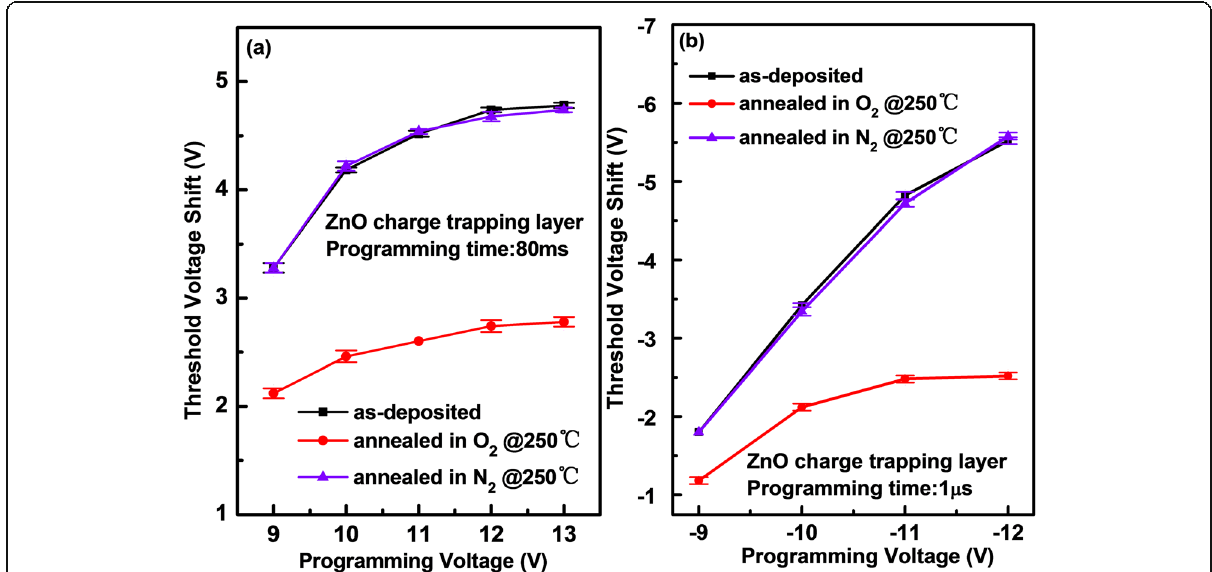
Fig. 5 The threshold voltage shifts of the a-IGZO TFT memory devices with different processed ZnO charge trapping layers as a function of a